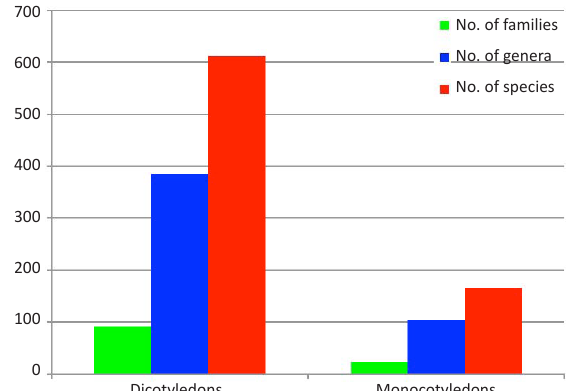
Figure 2. Floristic analysis of plants of Katerniaghat Wildlife Sanctuary